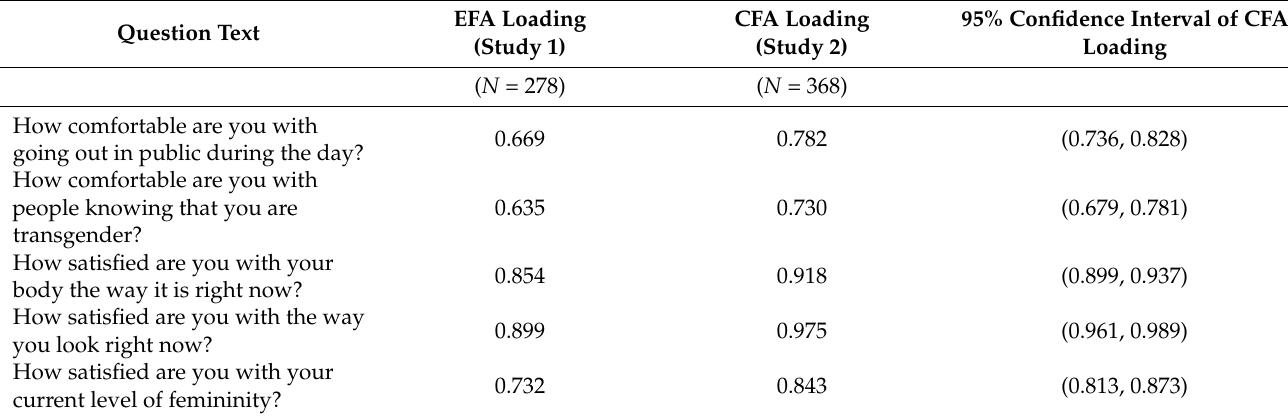
Table 2. Standardized factor loadings from factor analyses.